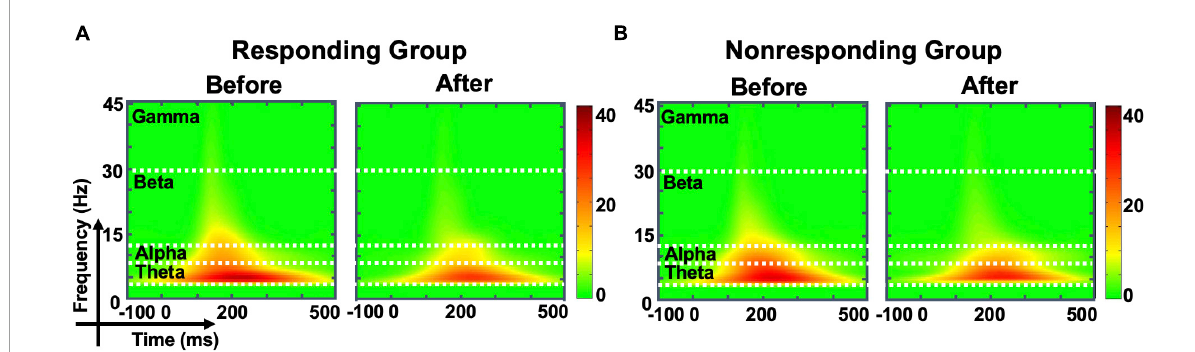
FIGURE3 The evoked oscillatory power in the whole brain. The time-frequency plot shows the average energy for all electrodes in the whole brain before and after multidisciplinary intensive rehabilitation treatment (MIRT) in responding (A) and non-responding groups (B) .